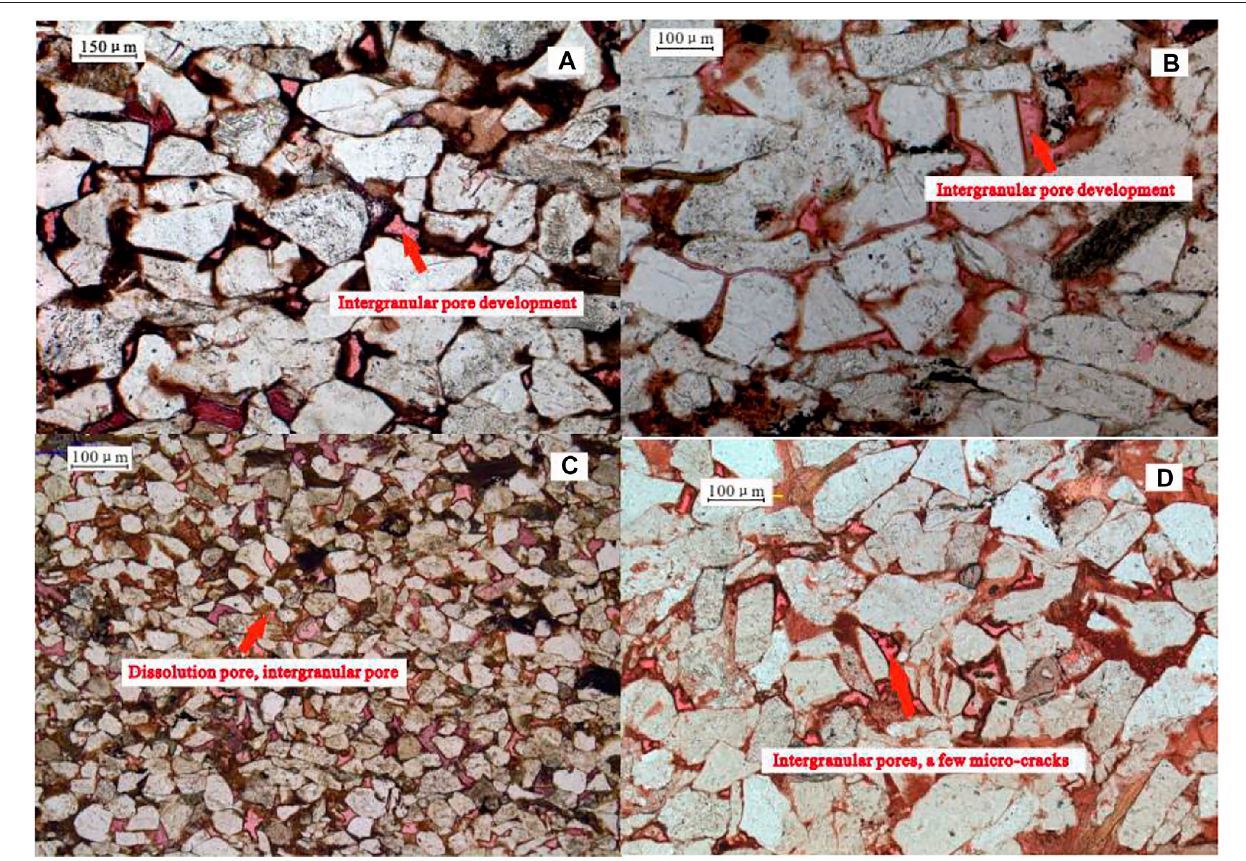
FIGURE 2 | Identi fi cation of typical sandstone thin sections of the Chang 6 reservoir in the Zhouwan-Wugucheng area. (A) Well B282, Chang 6 Member, 1852.75 m, isolated intergranular pores are developed; (B) Well B516, Chang 6 Member, 1785.94 m, intergranular pores are well-developed; (C) Well B513, Chang 6 Member, 1825.42 m, dissolution and intergranular pores; (D) Well B286, Chang 6 Member, 1773.97 m, intergranular pores and micro-cracks are developed.